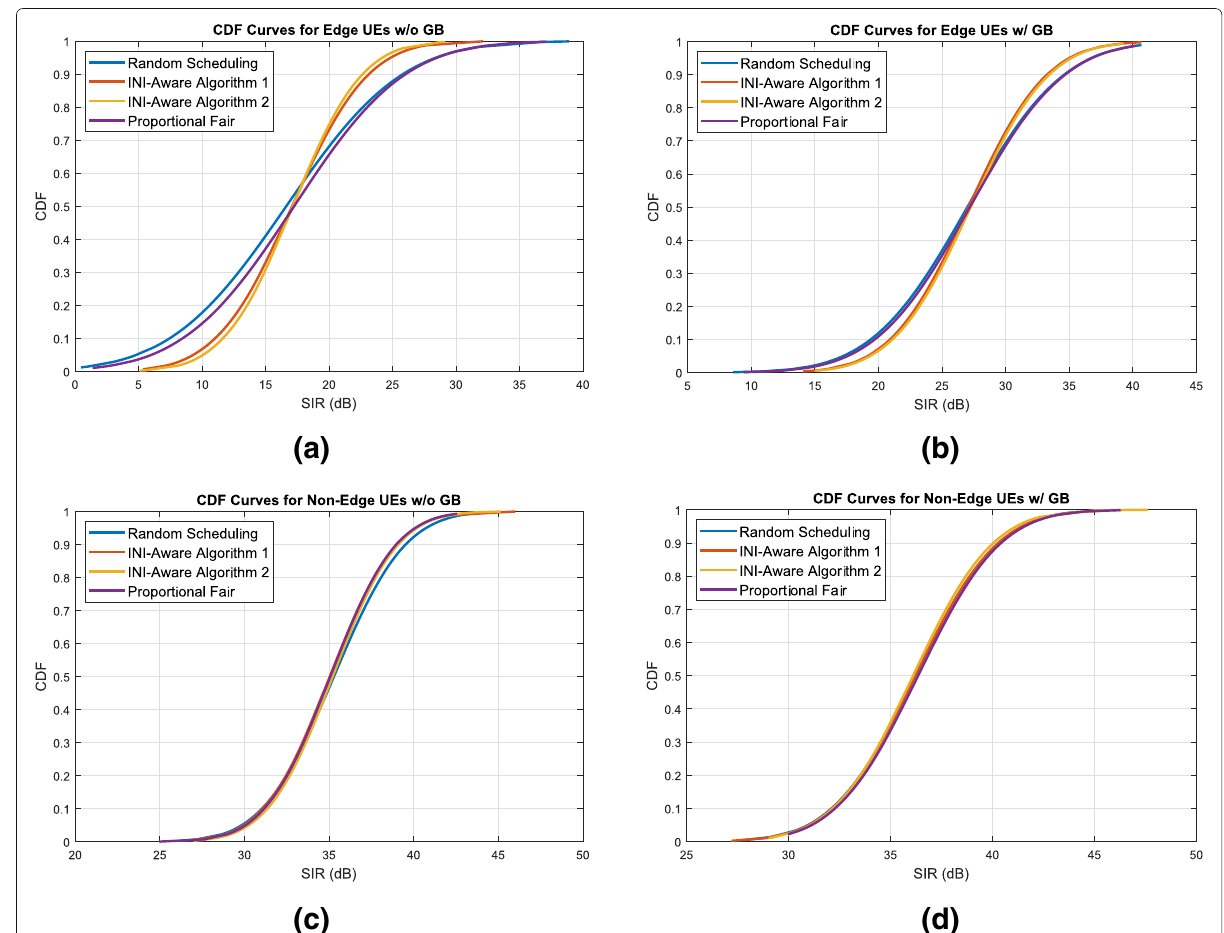
Fig. 9 The proposed fairness-aware scheduling algorithms compared to random scheduling. NUM-1 has a narrow SCs with 15 kHz (cid:2) f , and NUM-2 has a wide SCs with 30 kHz (cid:2) f . a CDF curves for the edge UEs without GB. b CDF curves for the edge UEs with GB. c CDF curves for the non-edge UEs without GB. d CDF curves for the non-edge UEs with